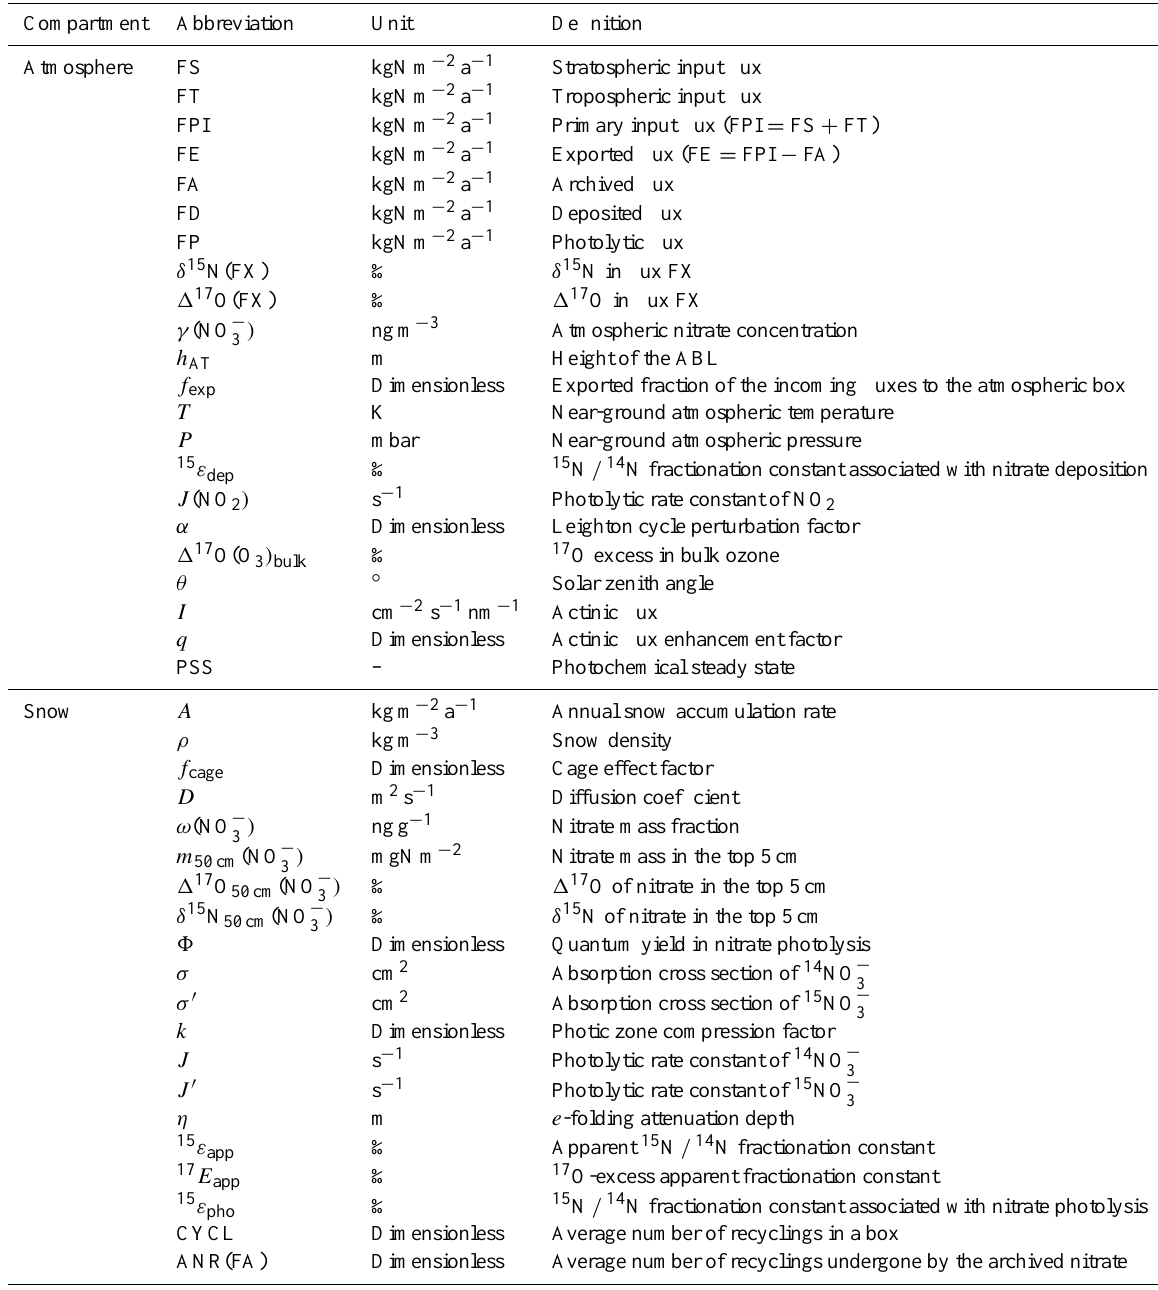
Table 1. List of the abbreviations used in this